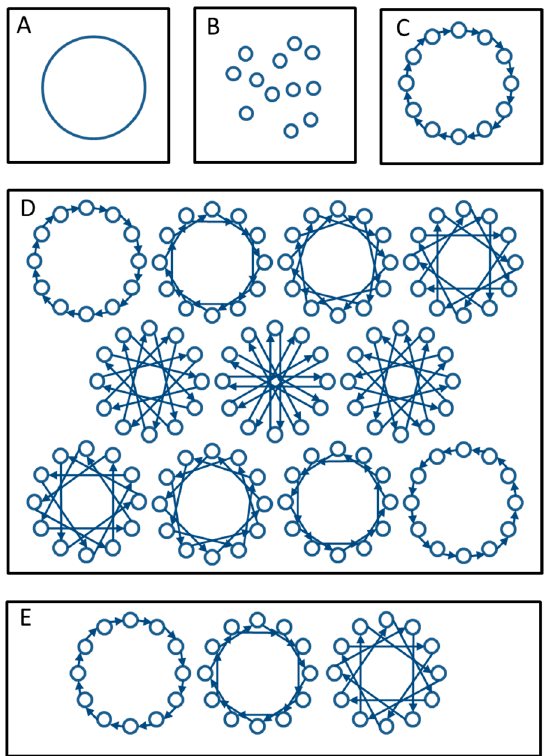
Figure 5. Breeding schemes, involving 12 groups, that were simulated using the Pointer software, including three schemes for rotational mating. Circles represent groups, arrows indicate exchange of animals, pointing from donor to recipient group. ( A ) Maintained as one single large group; ( B ) Isolated groups without exchange; ( C ) Breeding circle; ( D ) Falconer’s scheme; ( E ) Maximum avoidance of inbreeding. ( A )–( C ) each generation same scheme; ( D ) each 12th generation the same scheme; ( E ) each 4th year the same scheme.